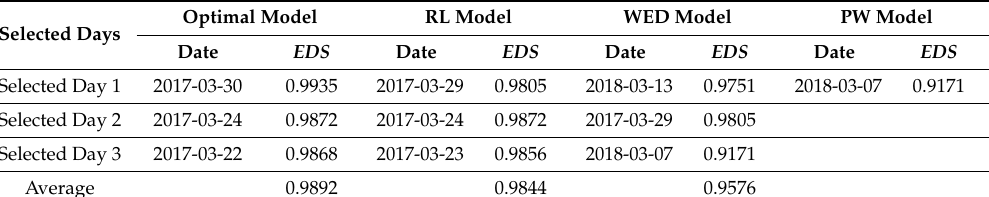
Table 3. Selected days and the Euclidean distance similarity ( EDS ) results of the models on 14 March 2018.